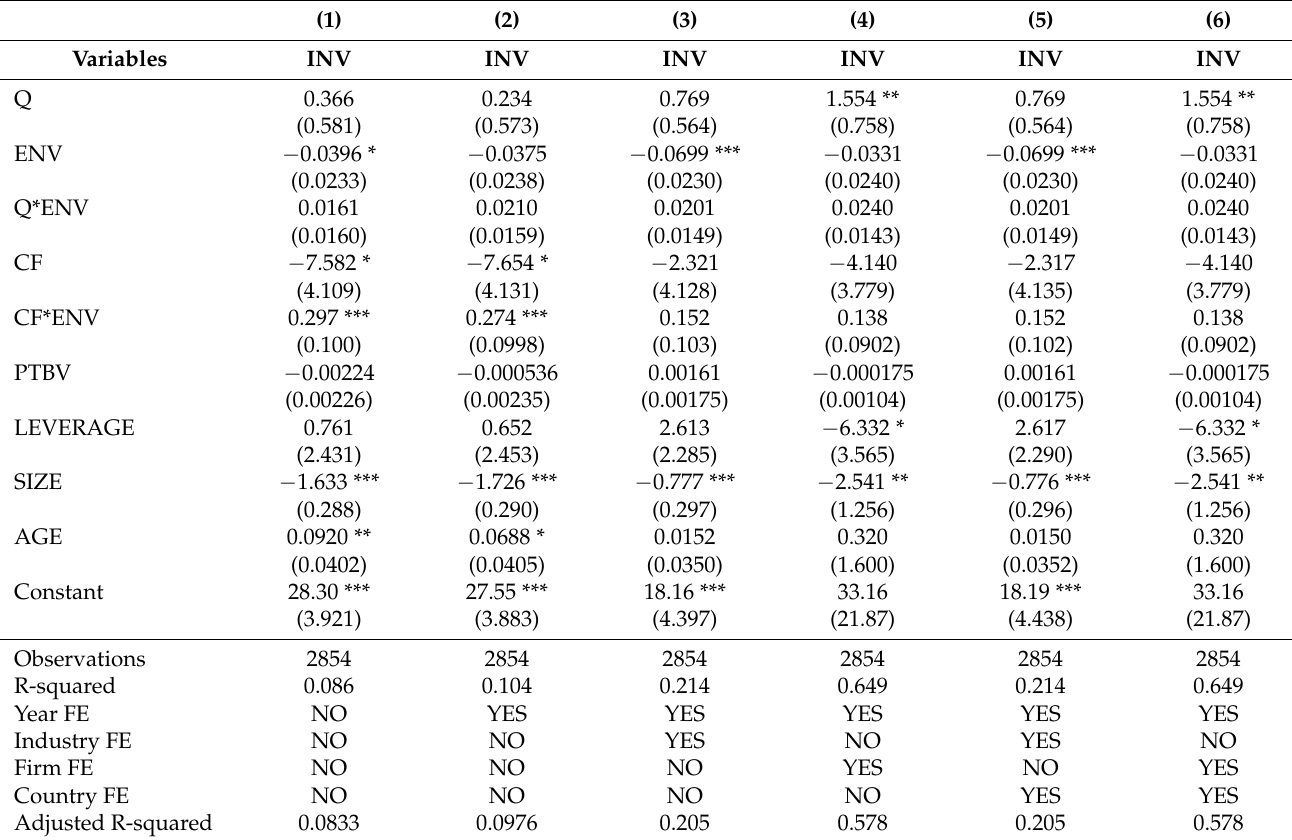
Table 3. Total environmental performance and investment